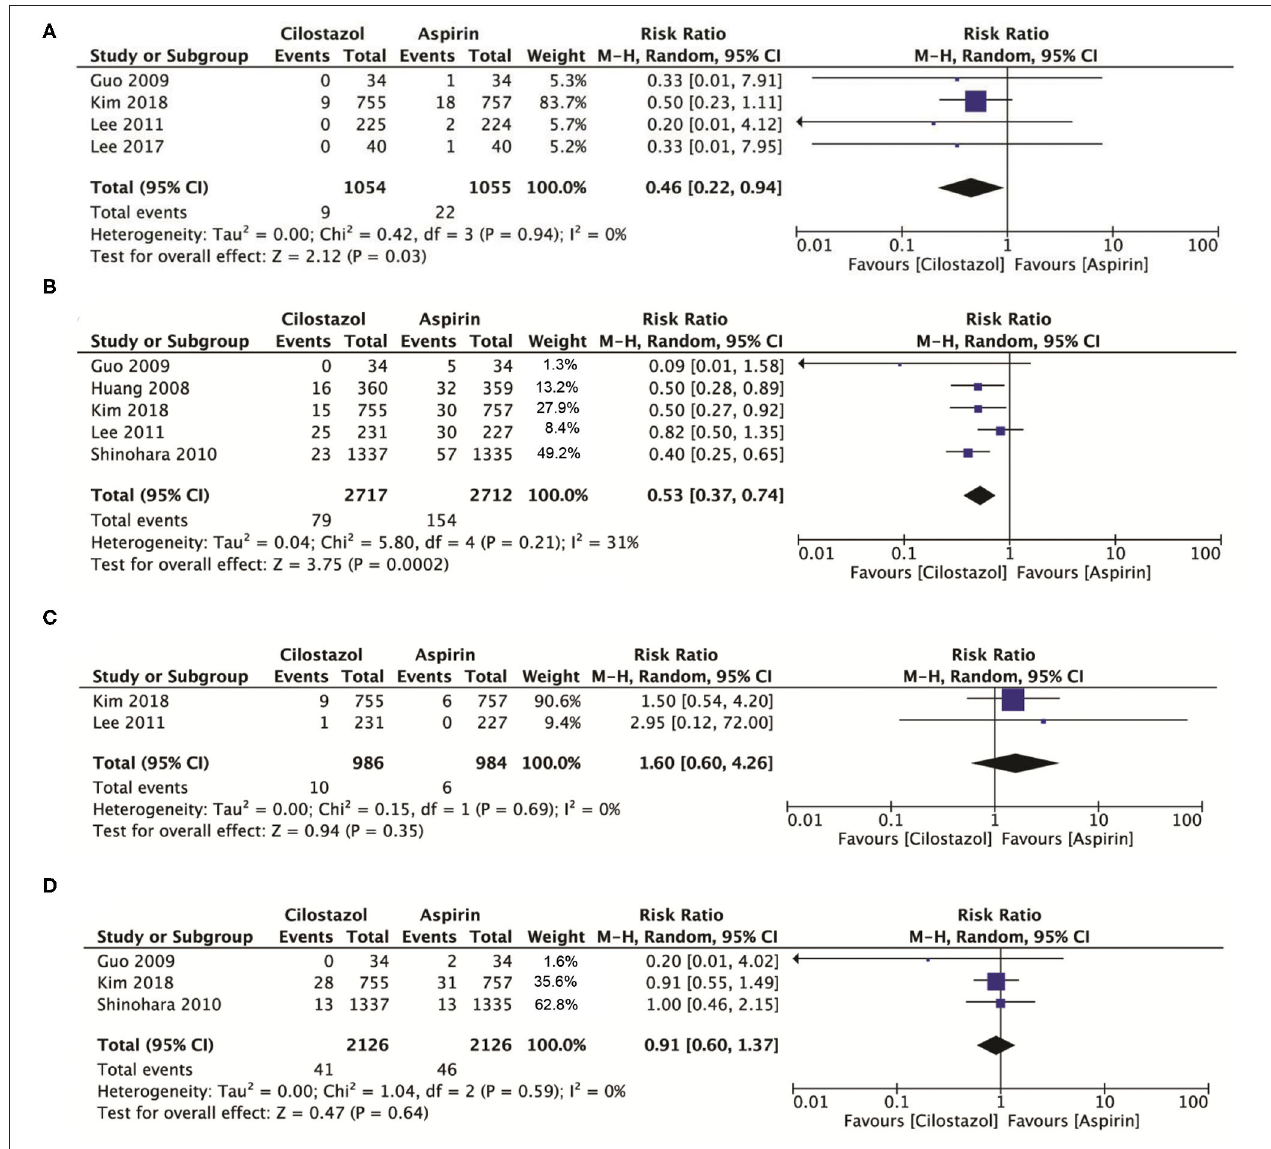
FIGURE 4 | (A) A forest plot of comparison: intracranial bleeding; (B) A forest plot of comparison: any bleeding; (C) A forest plot of comparison: vascular death; (D) A forest plot of comparison: any